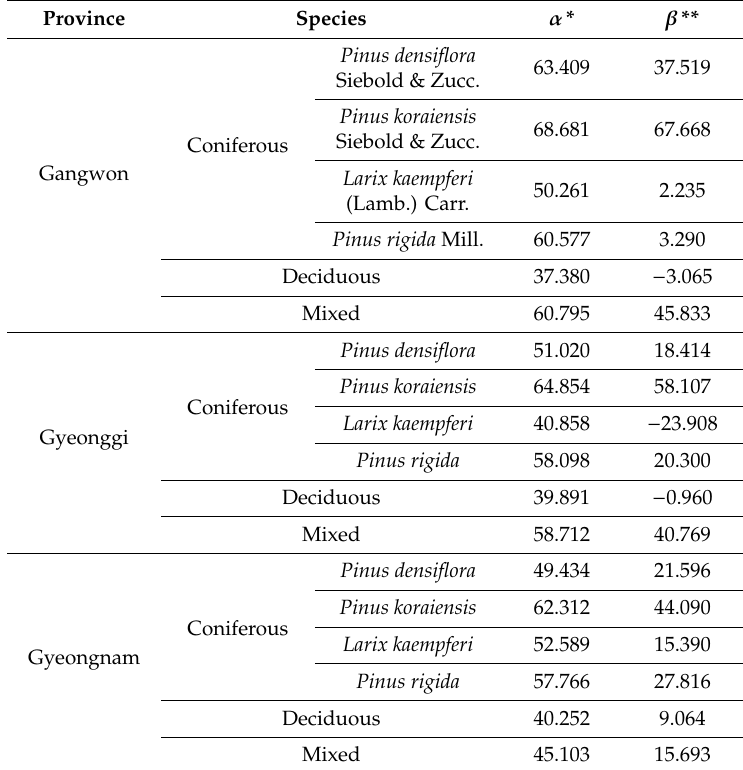
Table 2. Parameter values for forest volume estimation